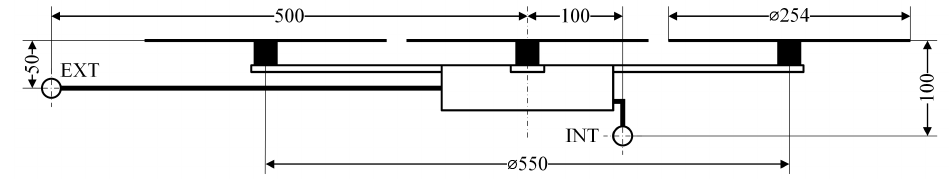
Figure 5. Final robot and measurement system schematic.